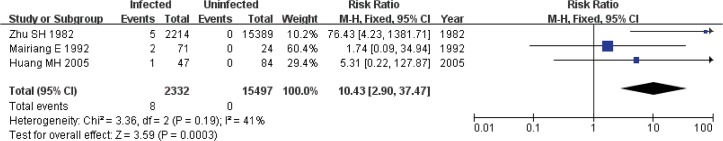
Forest plot of cohort studies on the relationship between liver fluke infection and cholangiocarcinoma.